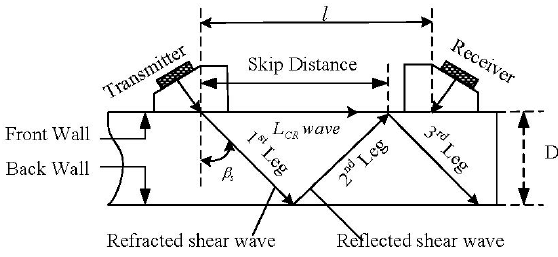
Figure 3. Distance between the transmitter and the receiver ( β S : the refraction angle, l : the distance between transmitting transducer and the first receiving transducer, and D : the plate thickness).